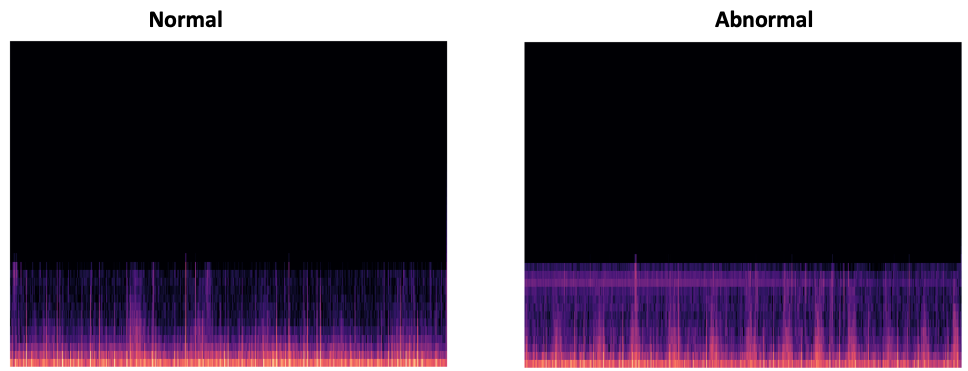
Figure 18. Overview of PCG spectrogram output (normal and abnormal,